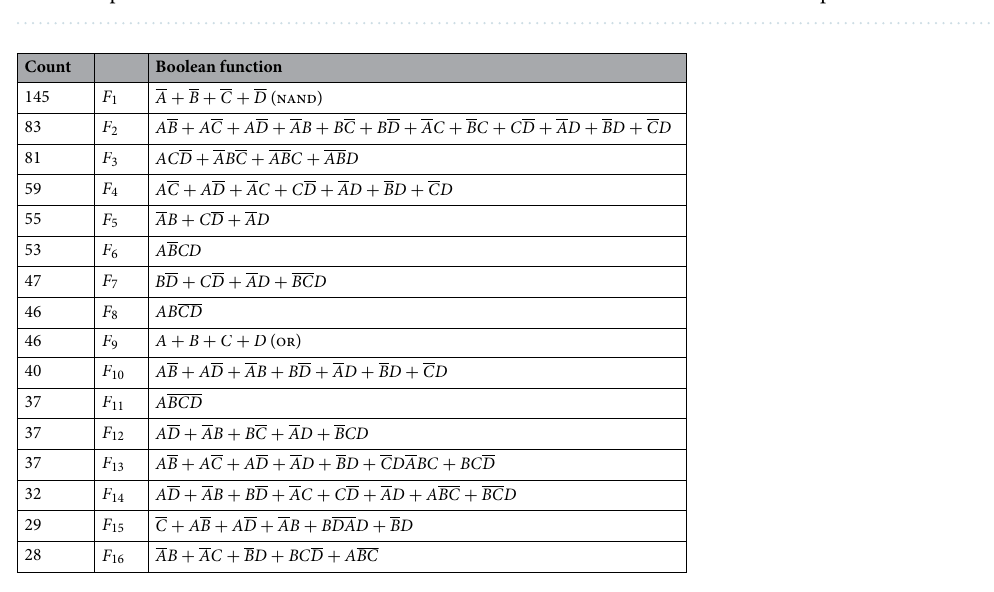
Figure 4. Counts of realised Boolean functions discovered in laboratory experiments. Horizontal axis is a decimal representation of functions. Vertical axis is a number of functions discovered in experiments.